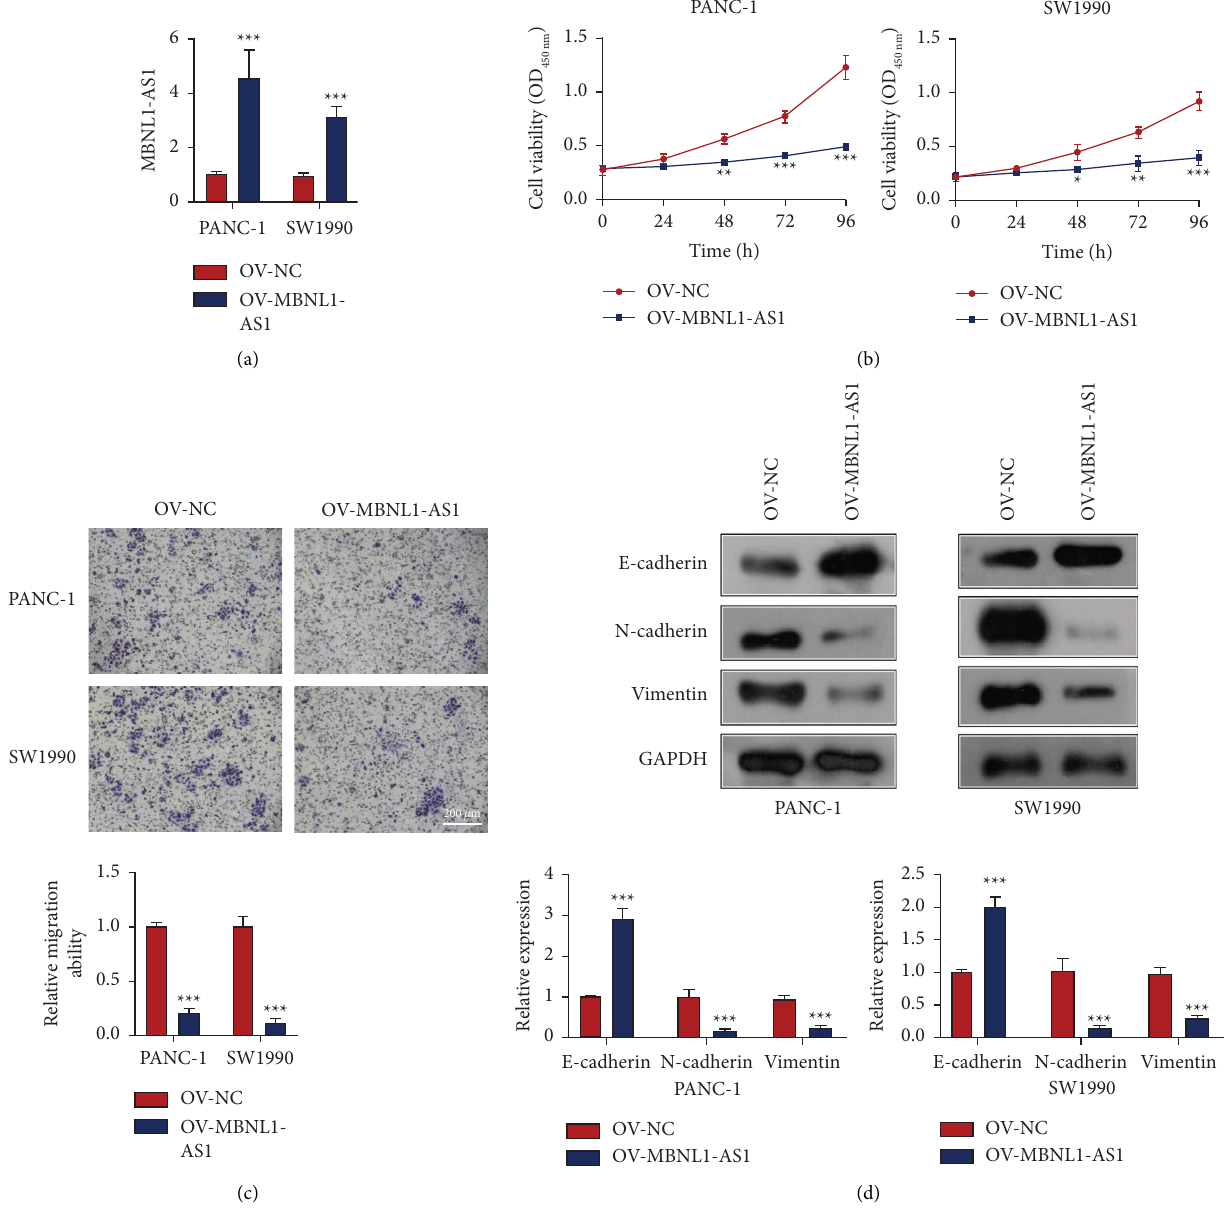
Figure 2: Overexpression of MBNL1-AS1 suppressed cell proliferation, migration, and EMT in PAAD. (a) Verifcation of efect of transfection with pcDNA-MBNL1-AS1 in PANC-1 and SW1990. (b) Cell viability of PANC-1 and SW1990 transfected with or without pcDNA-MBNL1-AS1 at diferent time. (c) Cell migration of PANC-1 and SW1990 transfected with or without pcDNA-MBNL1-AS1. Scale bar � 200 μ m. (d) Te EMTmarkers (E-cadherin, N-cadherin, and vimentin) in PANC-1 and SW1990 transfected with or without pcDNA- MBNL1-AS1. OV, means overexpression. Compared to the OV-NC group, ∗ P < 0 . 05, ∗∗ P < 0 . 01, and ∗∗∗ P < 0 .